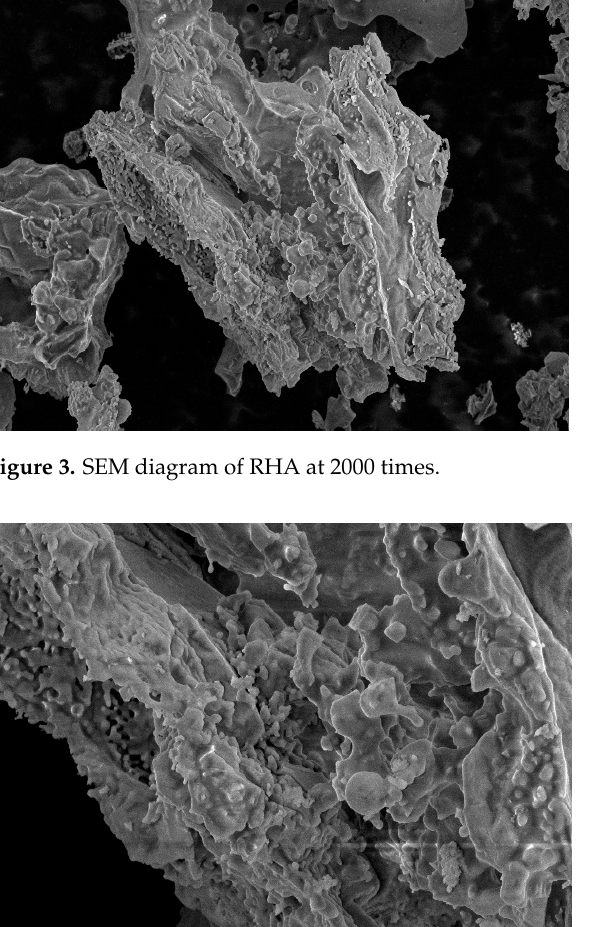
Table 2. Chemical composition of stabilized materials.